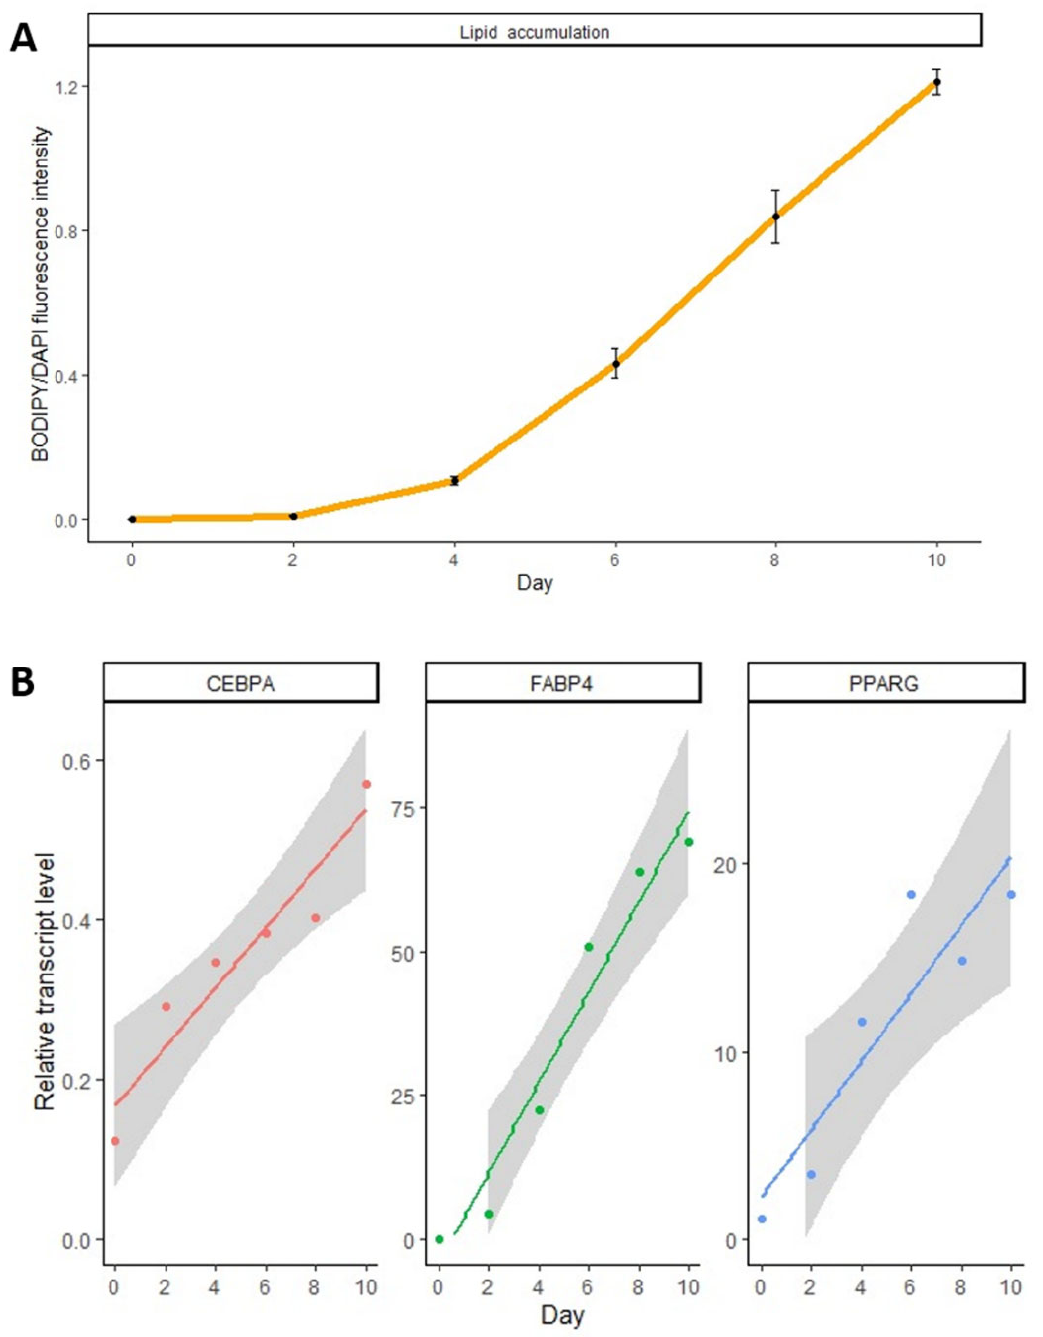
Figure 2. Monitoring of adipocyte differentiation. ( A ) Lipid droplet accumulation was quantified by measuring BODIPY 493/503/DAPI fluorescent intensity. Error bars show SDs. The error bars represent standard deviations. ( B ) Measurements of the relative transcript level of three genes: CEBPA , FABP4 , and PPARG. Each dot represents relative expression (mean of 3 repeats). The line is simple linear regression based on the collected data points and the gray area represents the 0.95 confidence interval for the regression line.